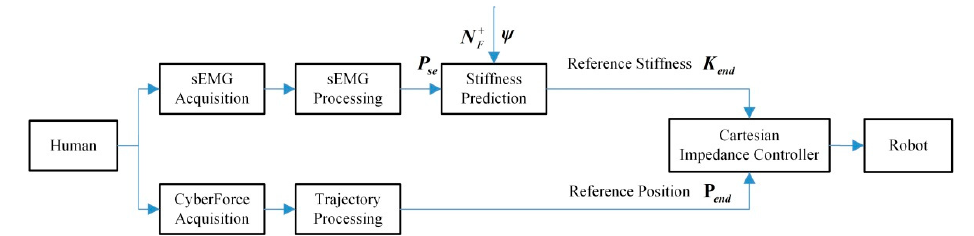
Figure 11. The overall block diagram of stiffness mapping for teleoperation.